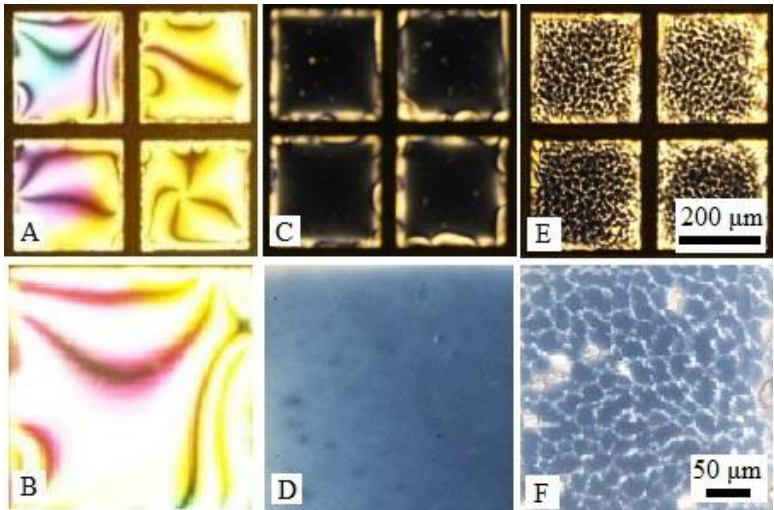
Figure 1. ( A ) Optical images (transmission through crossed polars) of 5CB before and ( B ) after exposure to aqueous (phosphate buffer saline (PBS)) dispersions of 20 µ M DNA-lipids for 1 h (magnified image); ( C ) Optical images of 5CB exposure to aqueous dispersions of 5 µ M L -DLPC for 1 h and ( D ) magnified image; ( E ) Optical images of 5CB exposure to aqueous dispersions of 20 µ M DNA-lipids and 5 µ M L -DLPC for 1 h and ( F ) magnified image.